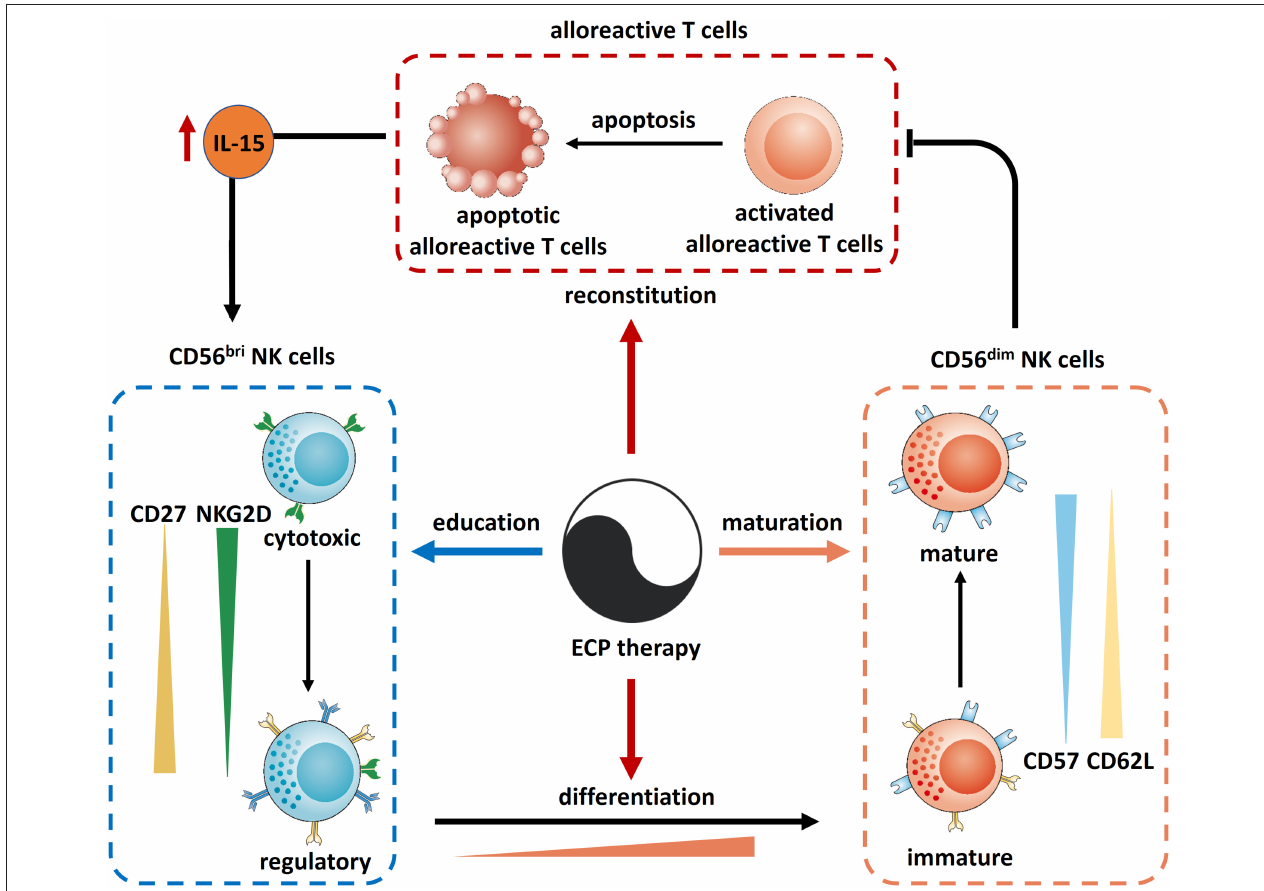
FIGURE 11 | Mechanism of action of ECP on NK cells in GVHD. Reconstitution: ECP could induce the apoptosis of alloreactive T cells resulting in an elevation of IL-15 which recoveries the immune reconstitution. Differentiation: IL-15 could also promote the differentiation of NK cells from CD56 bir subset to CD56 dim subset. In turn, CD56 dim NK cells could kill the alloreactive T cells. Maturation: CD56 dim NK cells could be matured through ECP therapy via upregulation of CD57 and downregulation of CD62L. Education: ECP could educate CD56 bri NK cells by shifting their quality from a cytotoxic to a regulatory function.